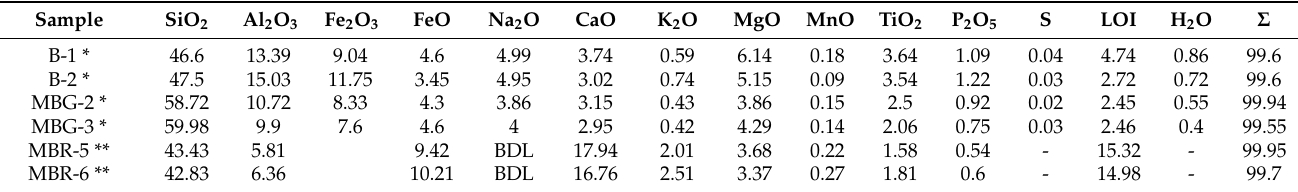
Table 1. Chemical composition of agate-bearing volcanics from the PrF, wt